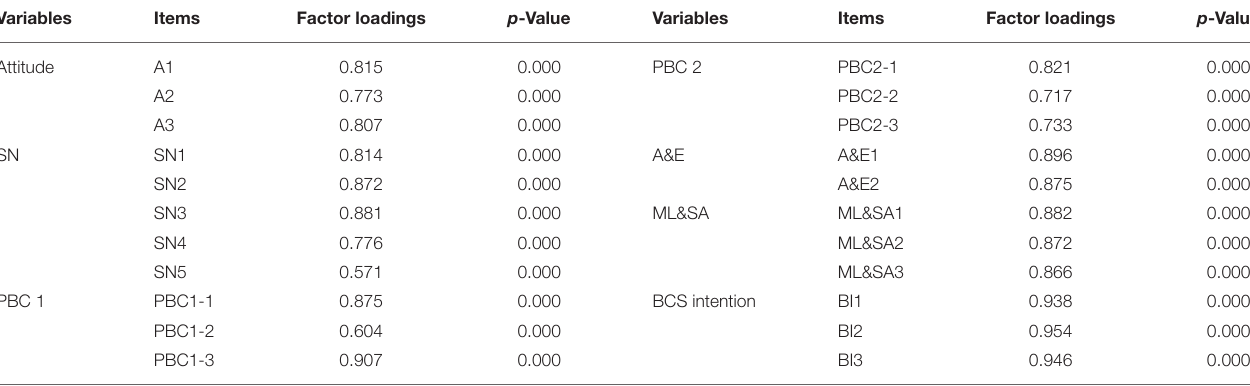
TABLE 3 | Factor loadings ( n = 3,011). Variables Items Factor loadings p -Value Variables Items Factor loadings p -Value Attitude